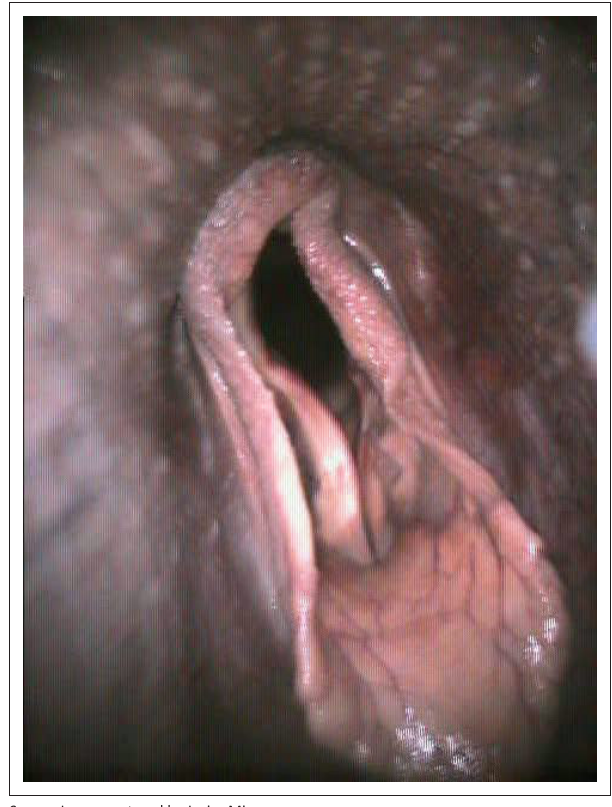
Source : Image captured by Javier Mirazo FIGURE 5: Multiple abnormalities observed in the study: left corniculate process collapse, axial deviation of aryepiglottic folds and vocal cord TABLE 2: Specific respiratory abnormalities (single and multiple) detected by dynamic overground endoscopy in 52 Thoroughbred racehorses examined from November 2011 to August 2012 in South Africa. Number of abnormalities Abnormalities Number of horses Percentage of total cases ( % ) 3